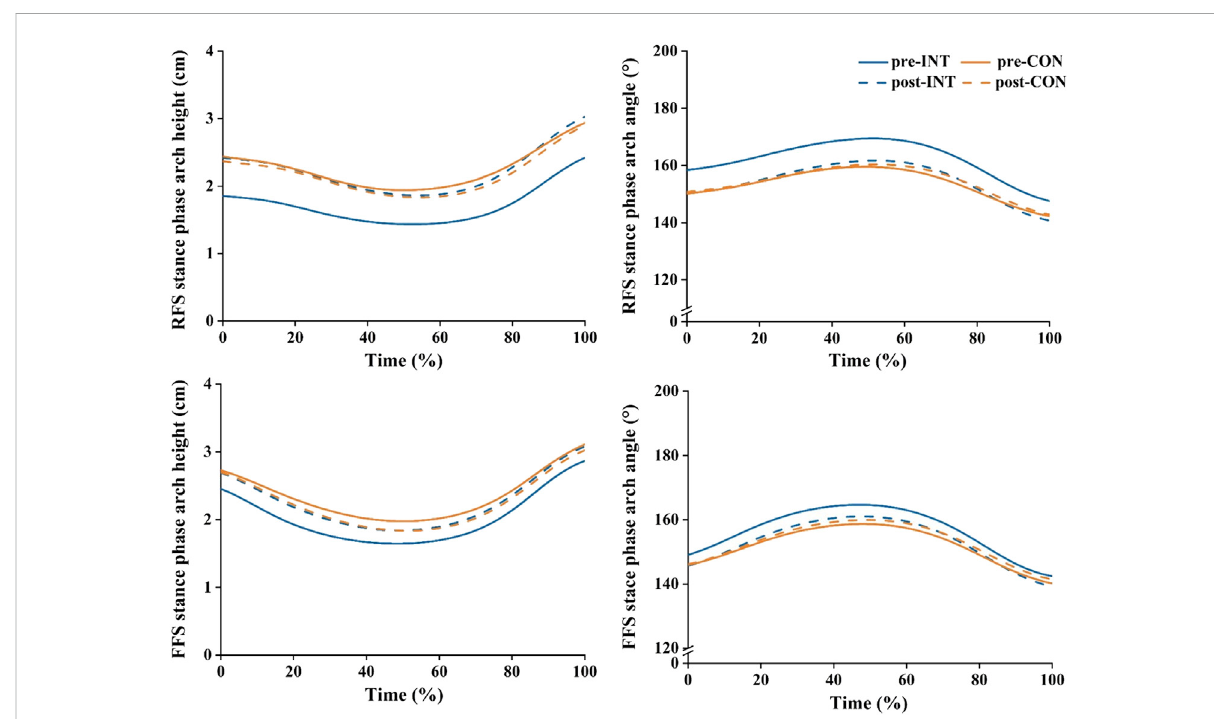
FIGURE 9 Effects of a 12-week gait retraining program combined with foot core exercise on the arch height and angle.